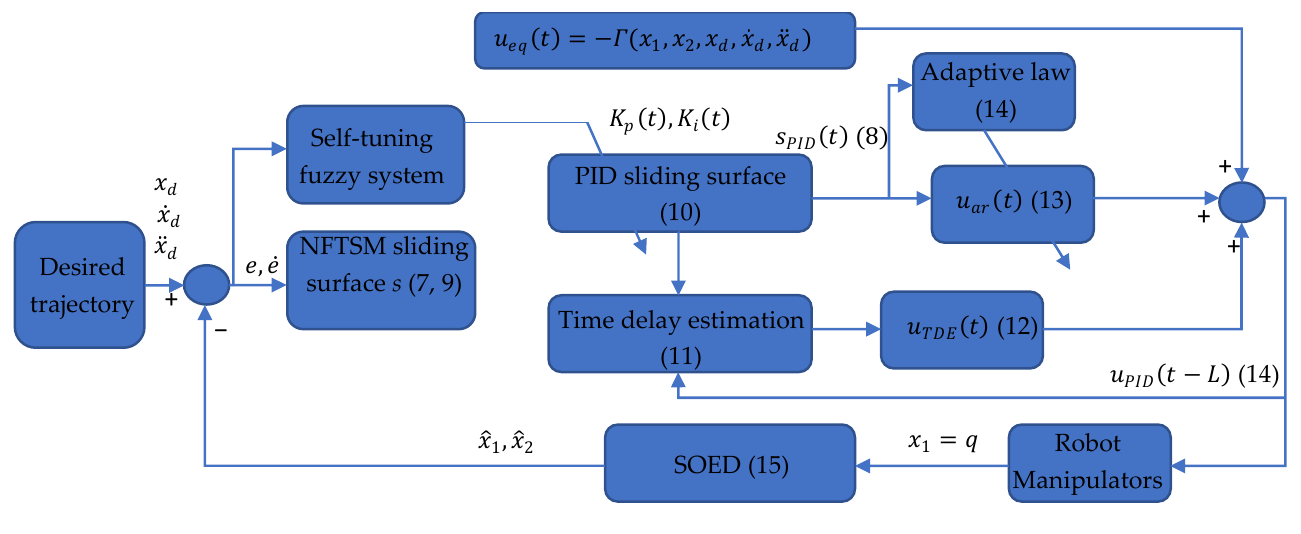
Figure 2. (SFT-PID-NFTSM) with (TDE) [25].